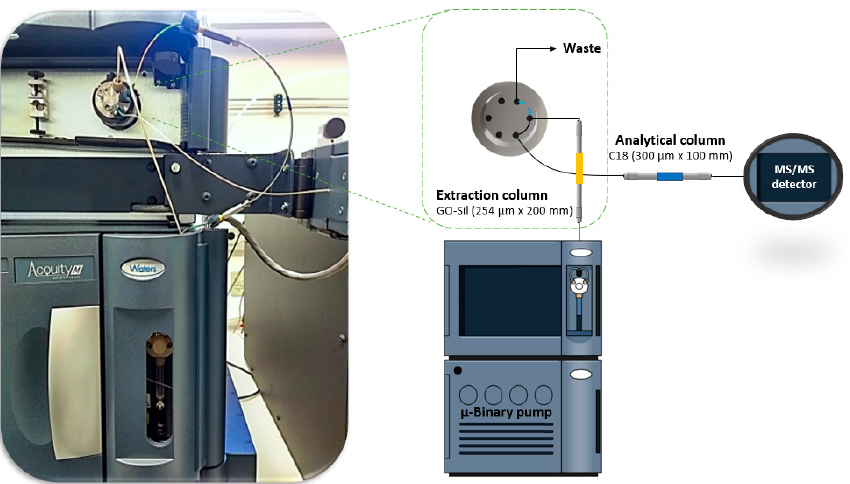
Figure 7. Representative scheme of the system 2 configuration. An actual photograph of the switching valve connections and the capillary extraction column is depicted in the left, while a drawing of the whole system is displayed on the right side of the figure.